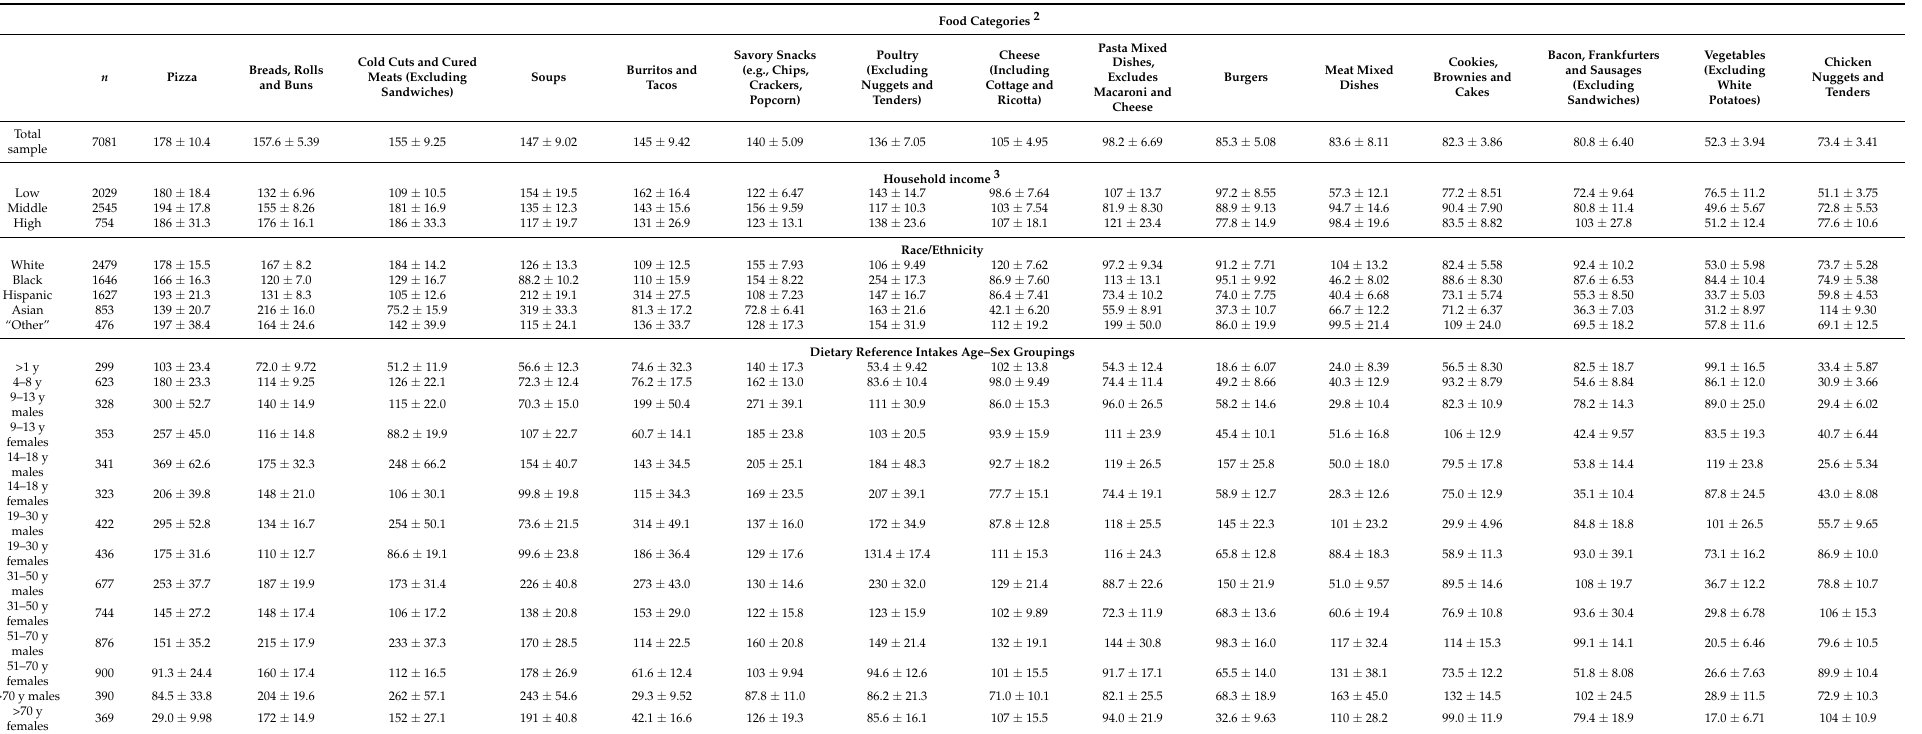
Table 3. Mean sodium intakes [mg/day ± SE ( n )] by top sodium-contributing categories, NHANES 2017–2018, for the total sample and by sub-groups, per capita (full sample) 1